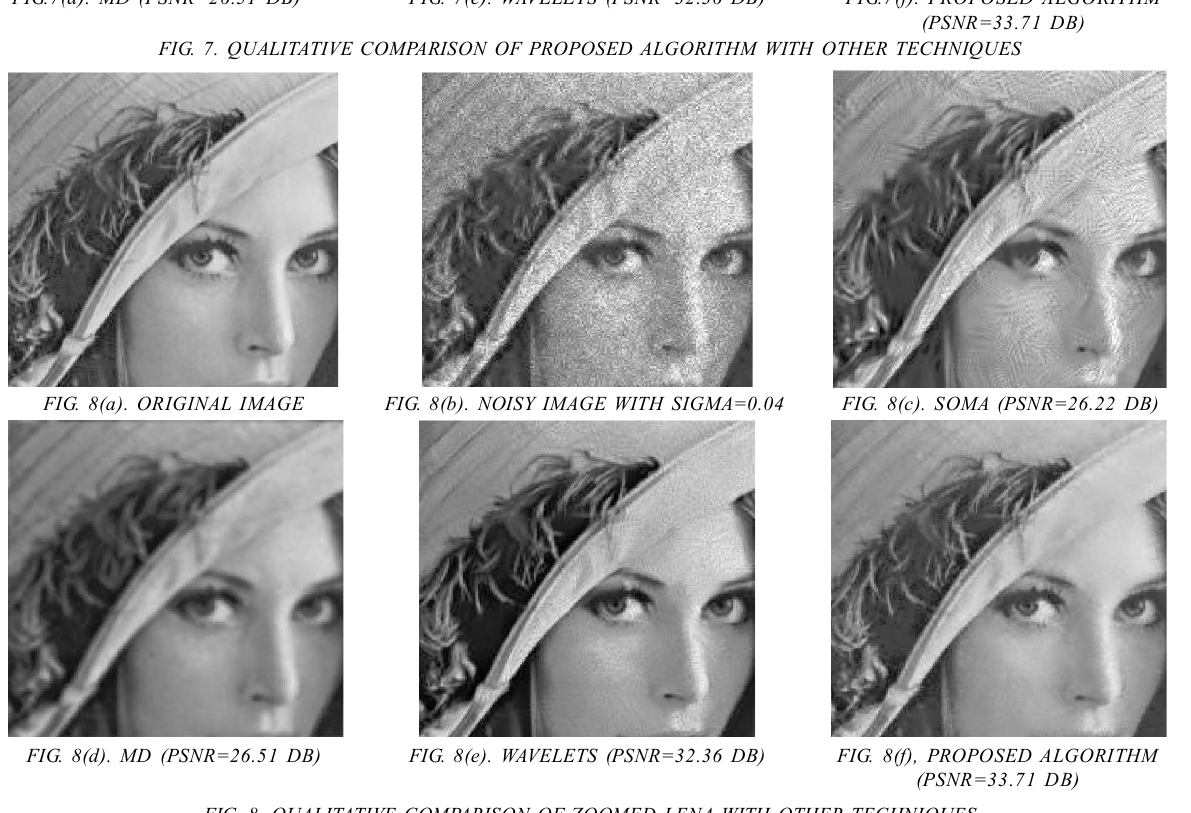
FIG. 7. QUALITATIVE COMPARISON OF PROPOSED ALGORITHM WITH OTHER